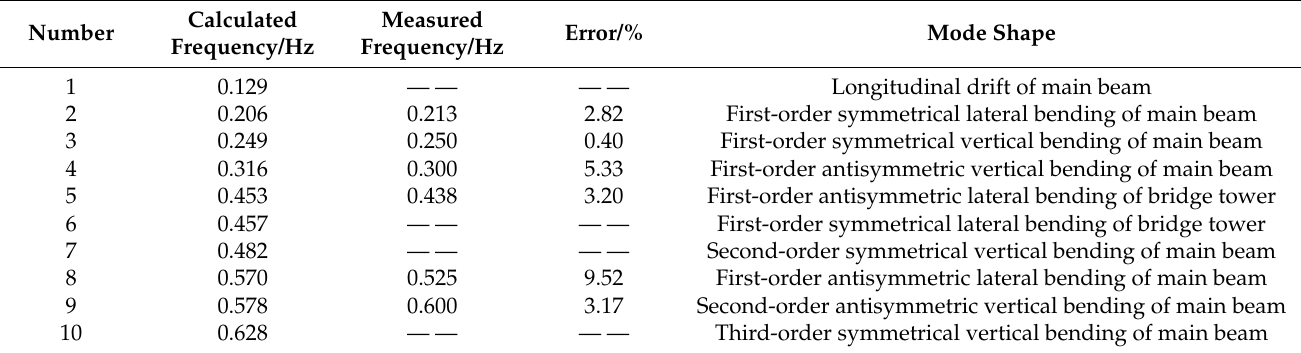
Table 1. Modal analysis results of Xiangshan Harbor Bridge.